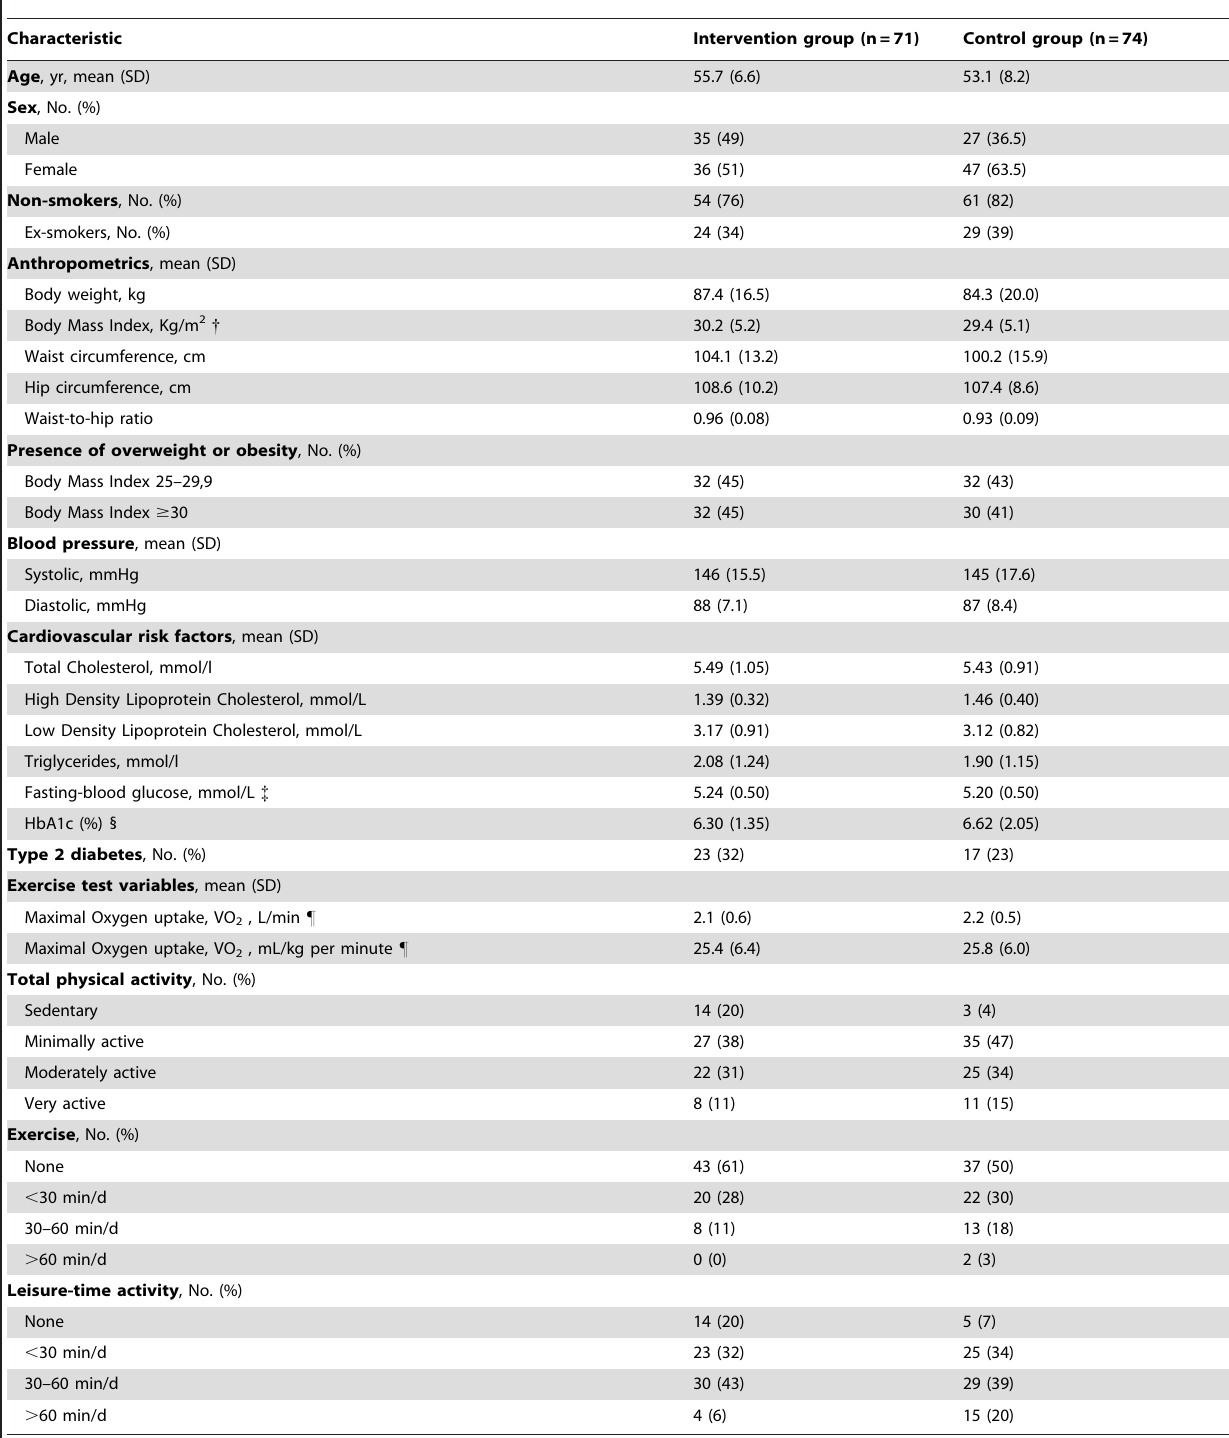
Table 2. Baseline Characteristics of randomised participants in the Swedish Bjo¨rkna¨s